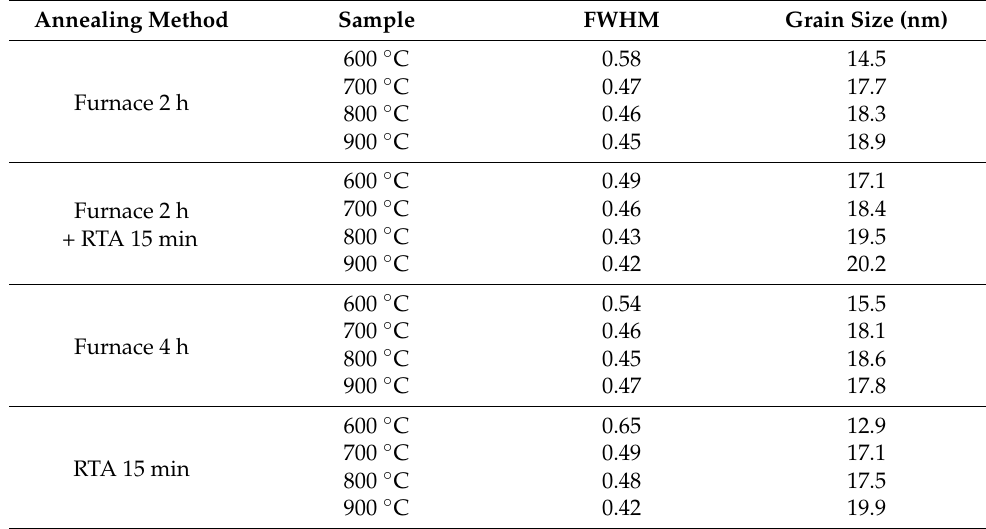
Table 1. FWHM and grain size of β -Ga 2 O 3 based on the different annealing